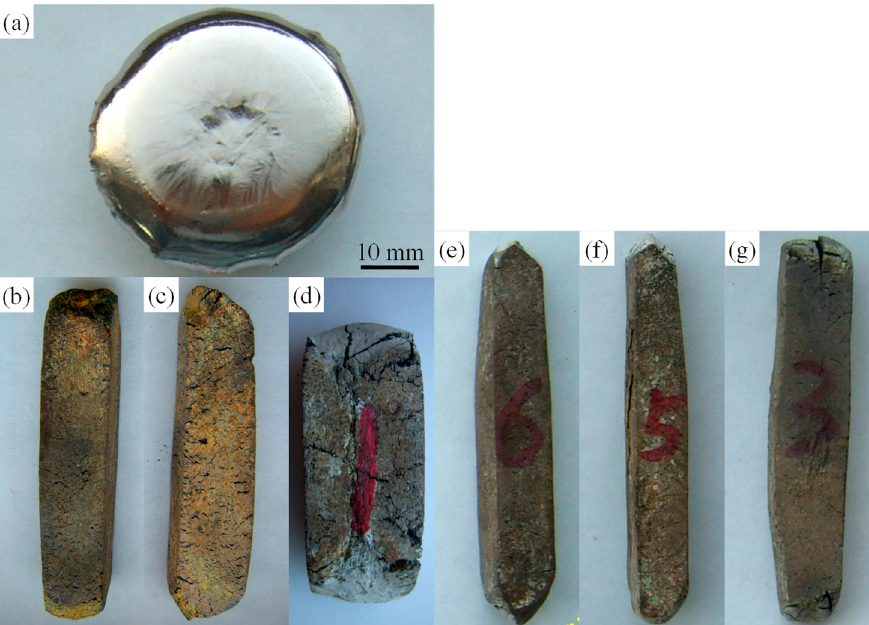
Figure 1. The morphologies of the 60 g ingot ( a ) and open-forged specimens ( b – g ). ( a ) 60 g ingot; ( b ) 2Zr-4O alloy; ( c ) 2Zr-6O alloy; ( d ) 2Zr-10O alloy; ( e ) 0Zr-4O alloy; ( f ) 0Zr-6O alloy; ( g ) 0Zr-10O alloy.